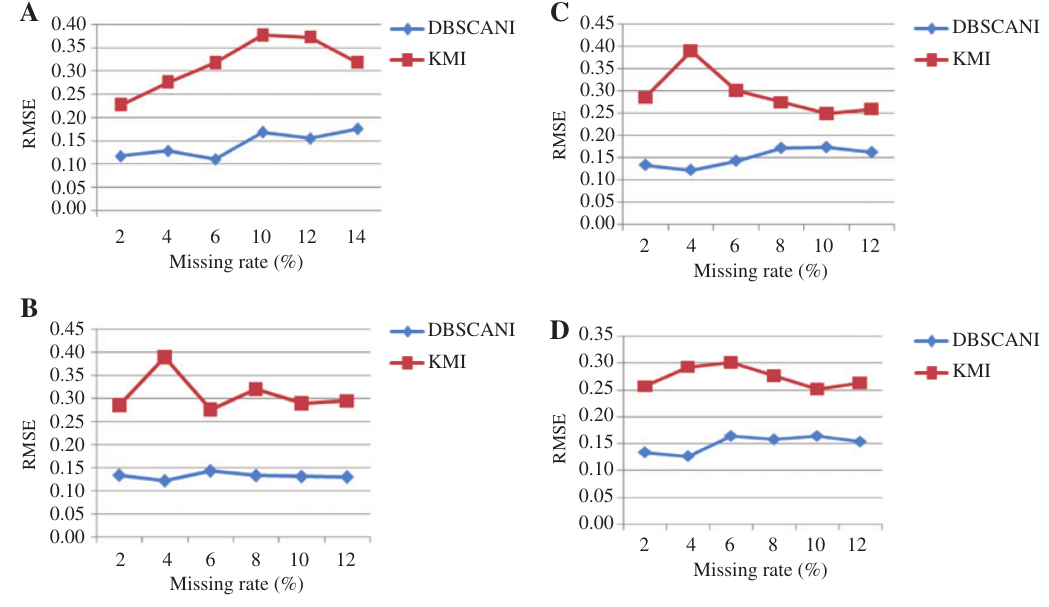
Figure 1: Experimental Results on Iris Data